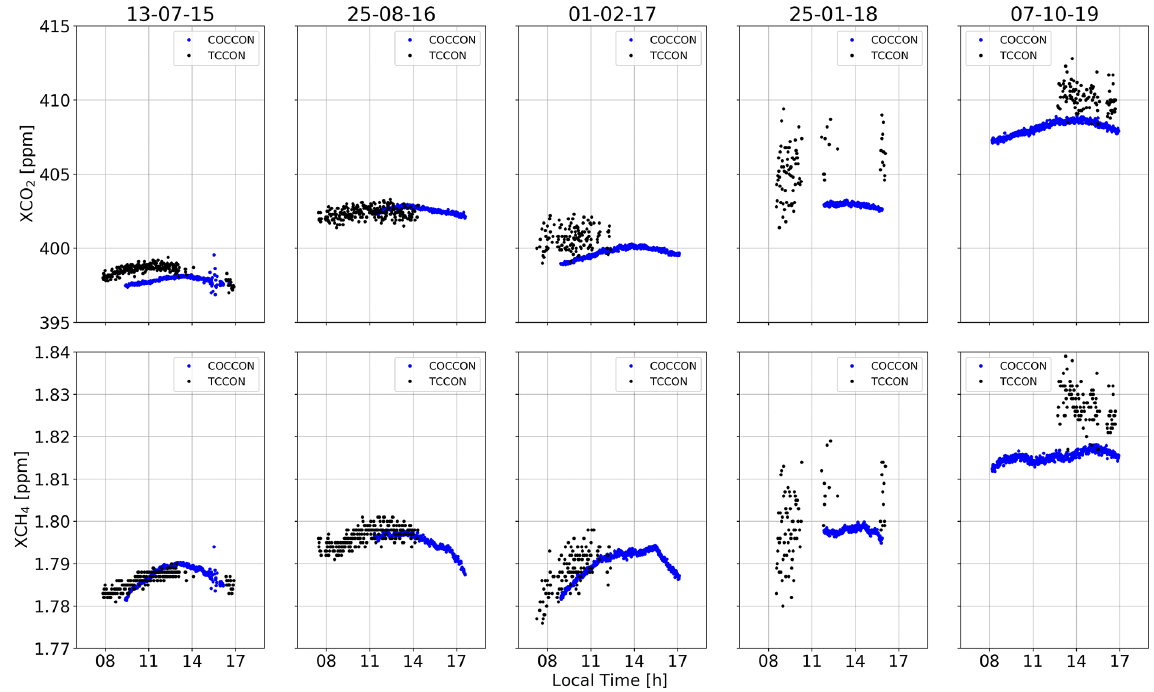
Figure B1. Comparisons of intraday XCO 2 and XCH 4 variability for 1d in 2015, 2016, 2017, 2018 and 2019 between the COCCON station Gobabeb (blue dots) and the TCCON Réunion Island station (black